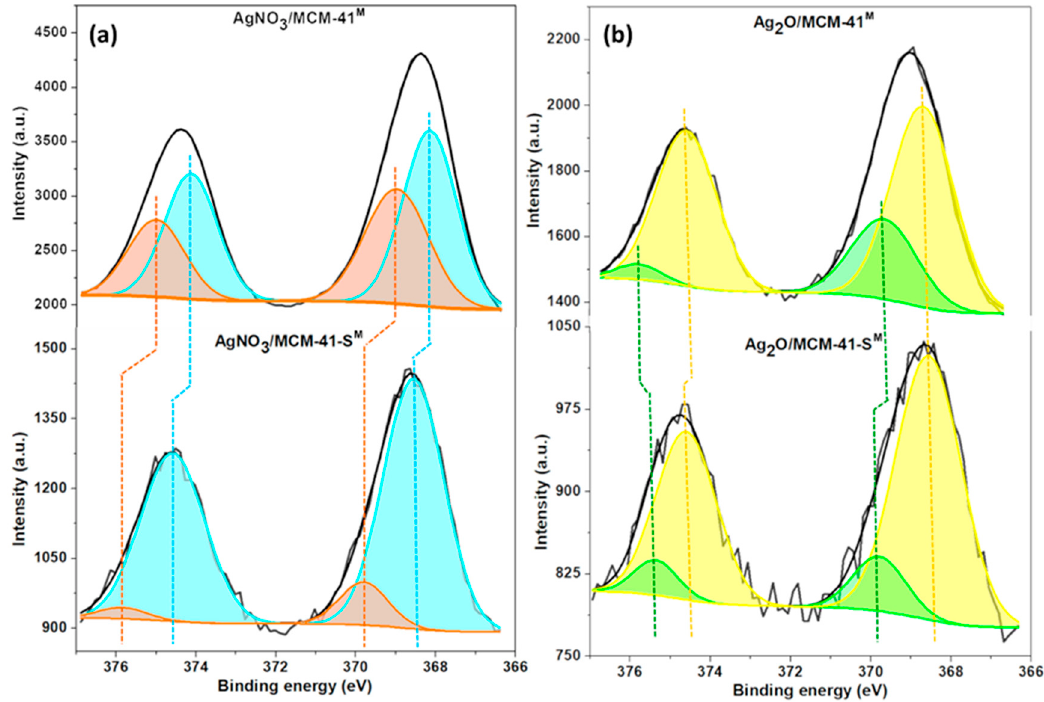
Figure 5. XPS spectra for ( a ) AgNO 3 / MCM-41 M and ( b ) Ag 2 O / MCM-41 M before and after desulfurization.